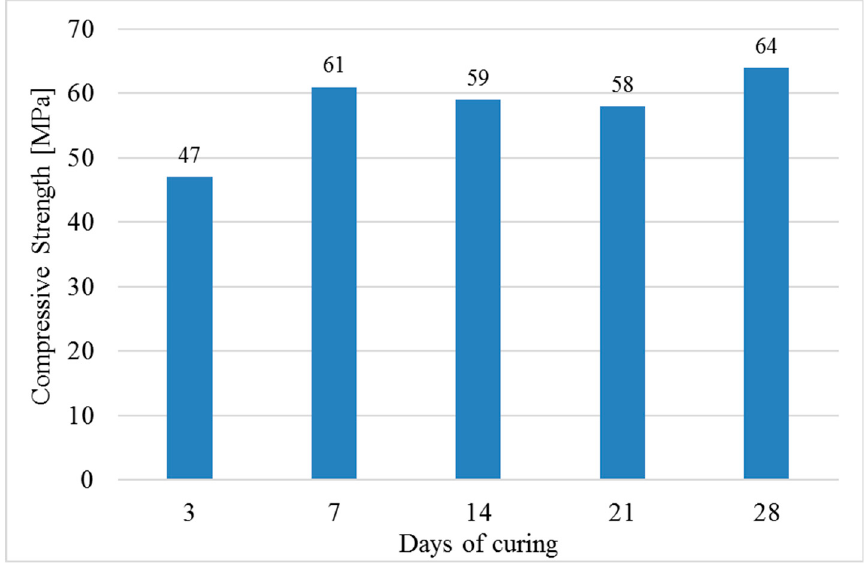
Figure 1. Compressive strength on alkali-activated mixture samples after 3, 7, 14, 21 and 28 days of curing.